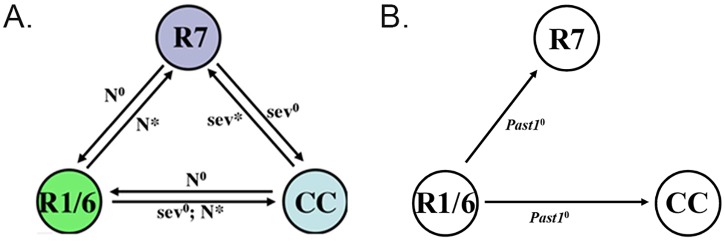
A model for ommatidium development.(A) According to Tomlinson et al. 2011, expression of Notch in R1 or R6 leads to their development into R7 or cone cells. (B) A model for ommatidium development, presenting the impact of Past1 mutation (Past1null) on development of R1/R6/R7 and the cone cells. We assume that when overexpressed there is PAST1-mediated downregulation of endocytic processes, as shown in Fig 10, and therefore it behaves like a mutant Past1, that leads to Notch overexpression.